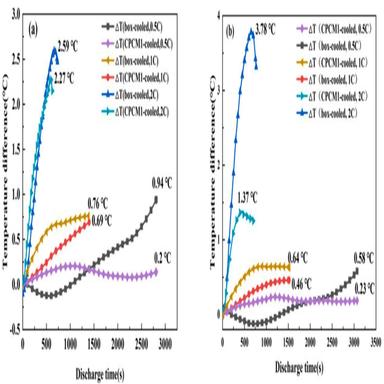
ΔT curves of the battery cooled by different methods at various discharge rates under two ambient temperature: (a) 25 ◦C, (b) 35 ◦C.